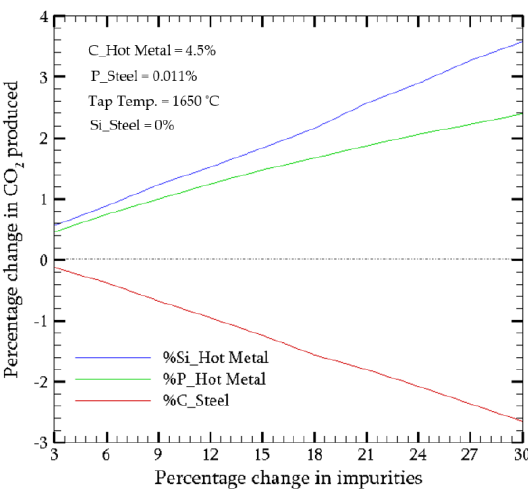
Figure 4. Sensitivity of impurities on CO 2.